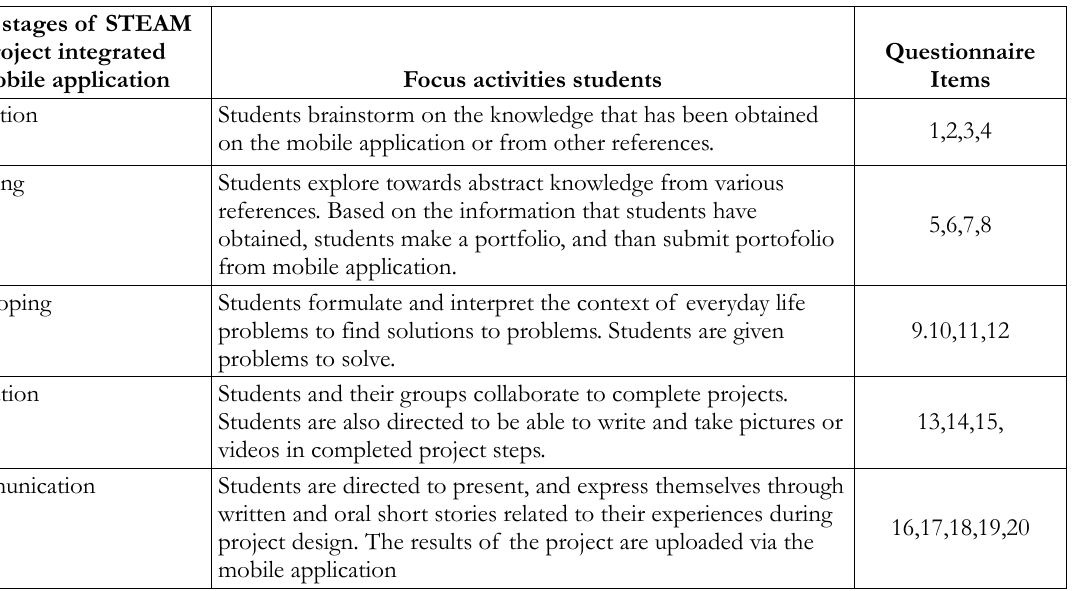
Table 4. Questionnaire of Implementation STEAM Project integrate mobile